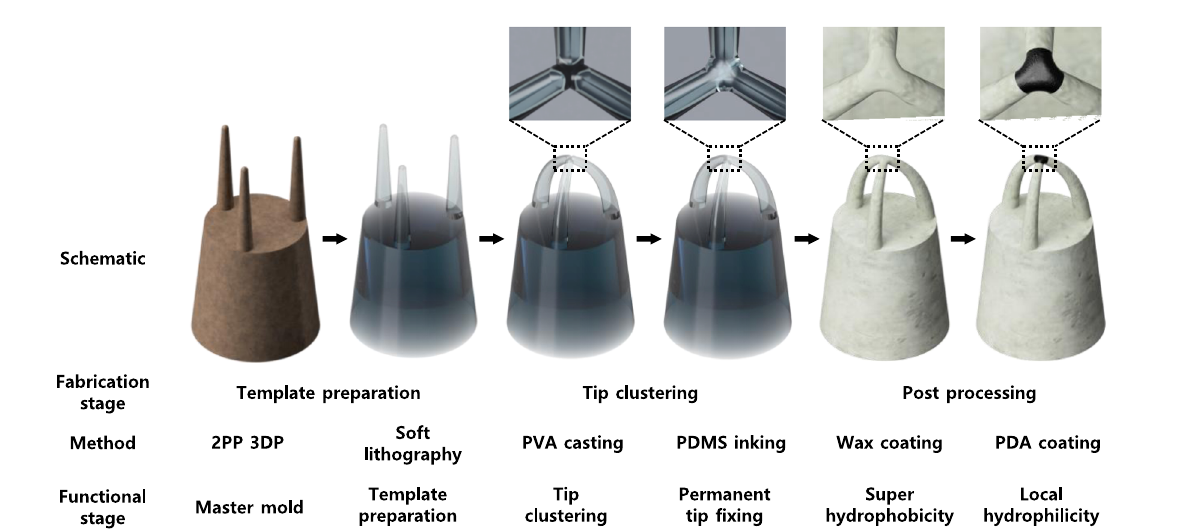
Fig. 4 | Schematics of the hierarchical pillar structure at each fabrication step. Eachschematicshowsthehierarchicalpillarstructureateachfabricationstep,from theoriginalmastermoldfabricatedby2PP3Dprintingsystem(leftmost)tothe fi nal